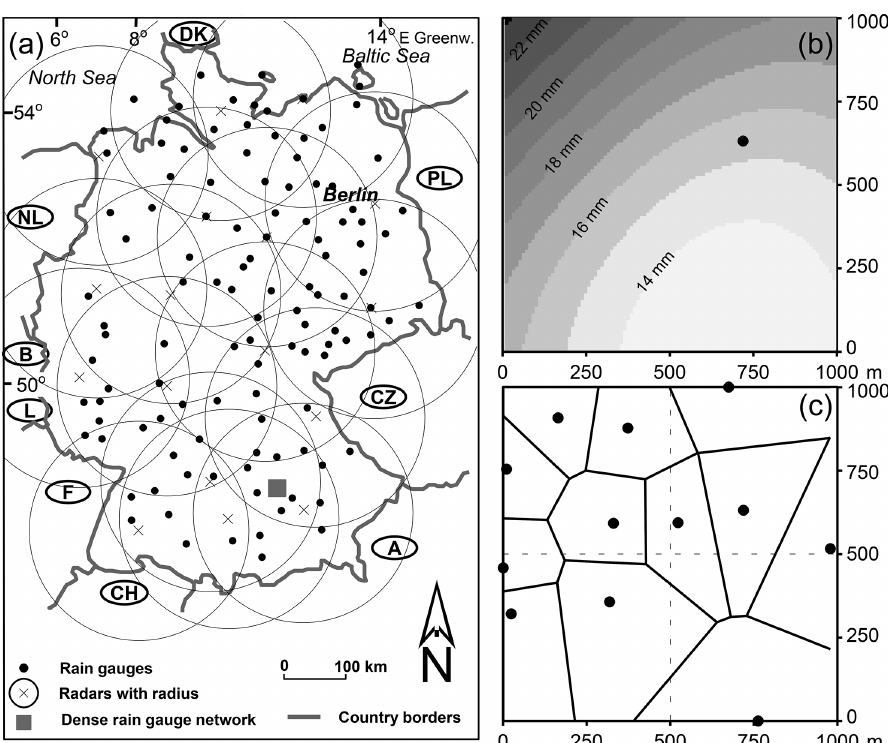
Figure 1. (a) Locations of the 115 rain gauges (dots), the coverage (circles) of the 17 weather radars (crosses) and the location of the 12 rain gauges used for the pseudo-radar data (square; size exaggerated) in Germany. (b) One rain gauge (dot) within one 1 × 1km 2 pixel (bounding box) and isolines of rain depth (taken from Fiener and Auerswald, 2009) illustrating the variability of a single erosive rain event at 1 × 1km 2 grid scale causing positional effects. (c) Distribution of the 12 rain gauges (dots) within an area of 1 × 1km 2 (bounding box) and their corresponding Thiessen polygons. Dashed lines separate the area to a spatial scale of 0 . 5 × 0 . 5km 2 . Table 1. Overview of the data used to determine the positional effect, the spatial-scale effect, the temporal-scale effect and the method effect. Purpose Measurement Spatial Temporal Number of Period Event scale scale stations/pixels number Positional and spatial-scale effect Rain gauge Spatial-scale and method effect Rain gauge Temporal-scale effect Rain